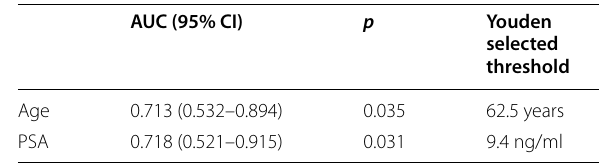
Table 6 Diagnostic results of age and PSA for 68 Ga-PSMA PET/CT on all low-risk and intermediate-risk prostate cancer patients